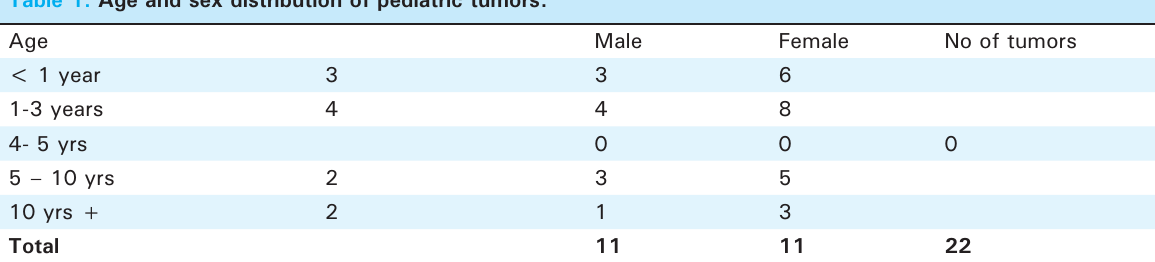
Table 1. Age and sex distribution of pediatric tumors.